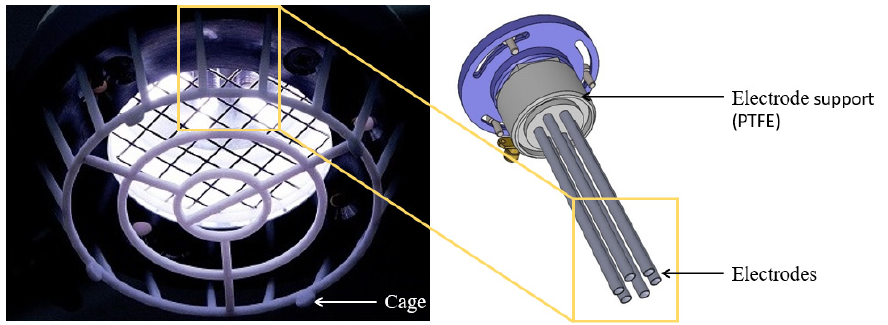
Figure 1. Photograph ( left ) of the SteriPlas plasma torch and CAD model ( right ) of the electrode.